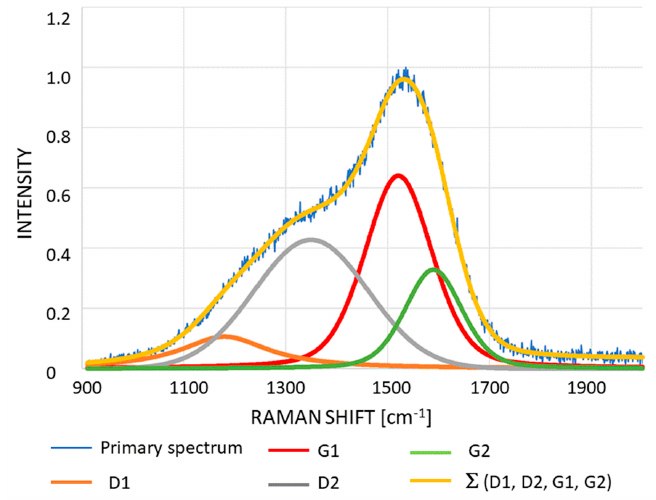
Figure 3. Raman spectra of examined samples.